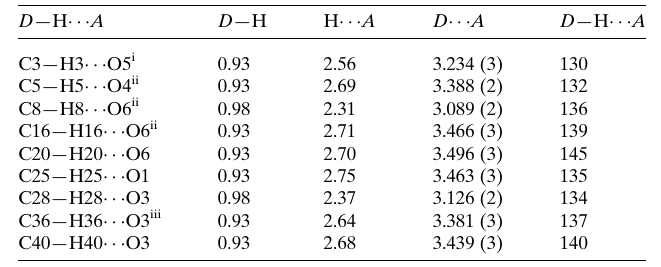
Table 2 Hydrogen-bond geometry (A˚ , (cid:3) ) for 2